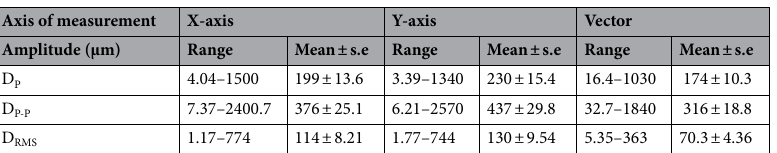
Table 2. Summary statistics across all samples of three measures of displacement amplitude (µm) of both focal and non-focal anthers combined. The axis of measurement indicates whether the displacement was measured in the x-axis, the y-axes, or the resulting vector calculated from the combined x–y displacement (see “Materials and methods” section).